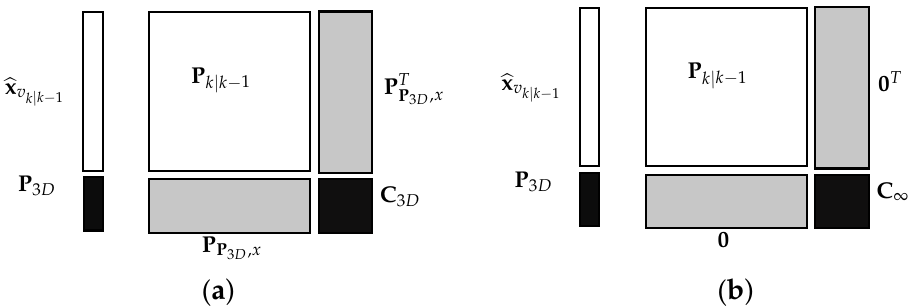
Figure 2. ( a ) represents the classical map state appended upon landmark initialization. The appended parts correspond to the landmark’s mean and covariance (black) and the cross-variances between the landmark and the rest of the map (gray). ( b ) represents the appended solution used followed by an update under